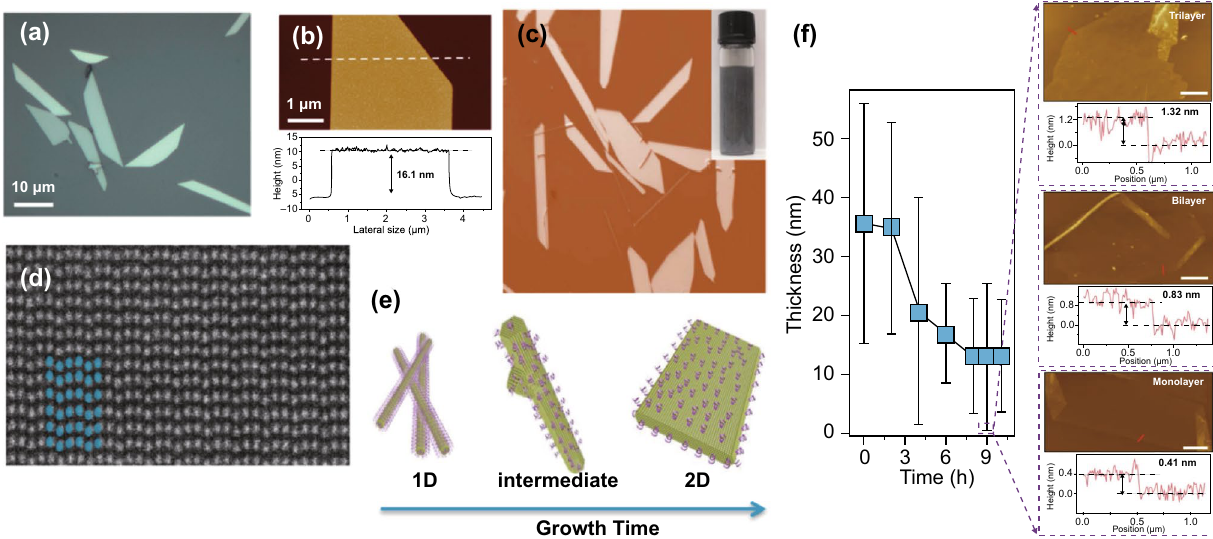
Fig. 4 a Optical image of the 2D Te nanoplates. b AFM image of 2D Te nanoplate with height profile. Adapted with permission from [26]. Copyright 2018, American Chemical Society. c , d Optical and HAADF–STEM images of 2D Te nanoplates. e Morphology evolution process from 1D to 2D Te. f Post‑growth thinning process to obtain few‑ and single‑layer Te flakes (solution pH = 10.5). Adapted with permission from [25]. Copyright 2018, Nature Publishing